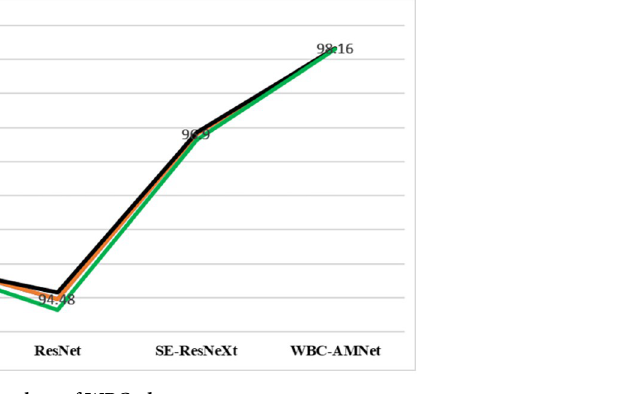
Fig 7. Tri-classification line chart of WBCs